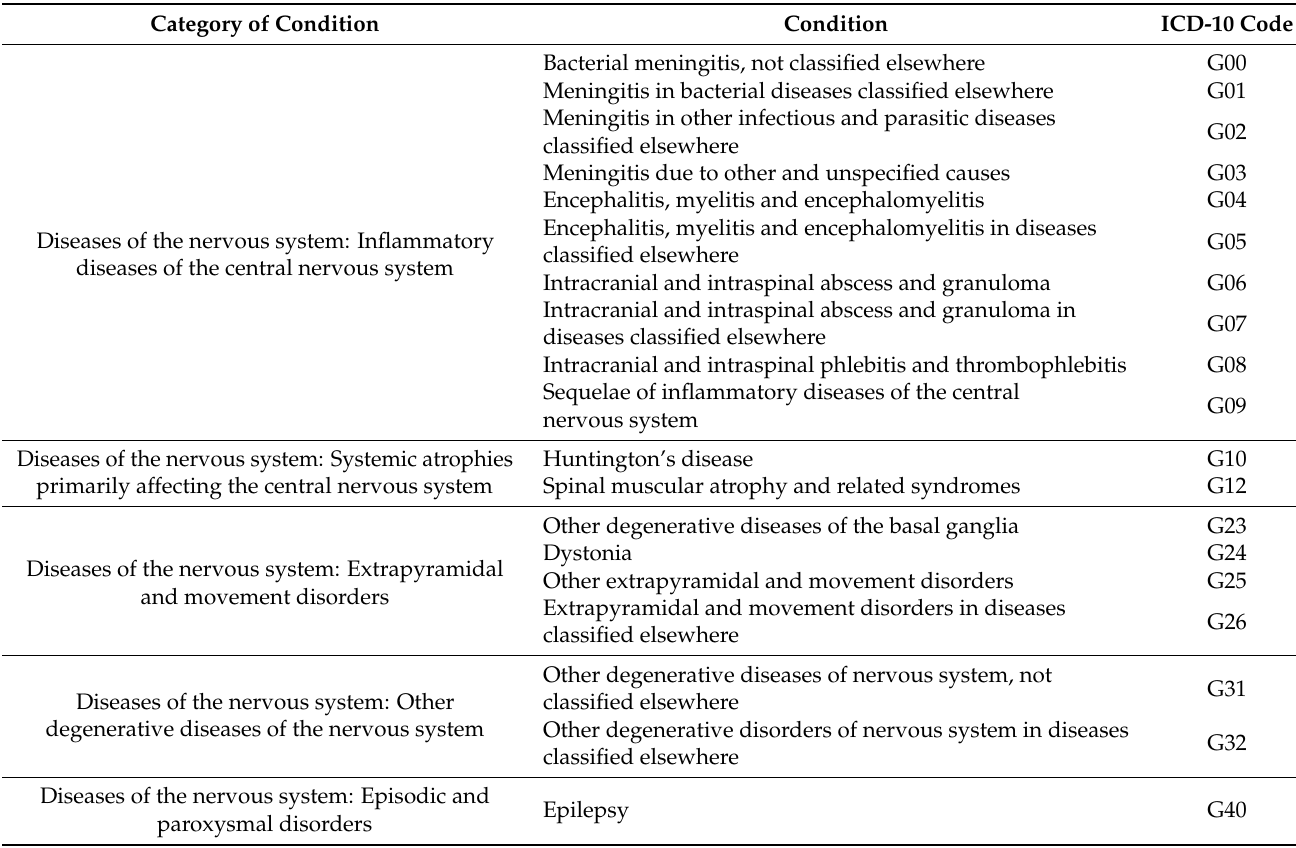
Table A1. The ICD-10 codes used to identify children who may have a high risk of febrile seizures. Category of